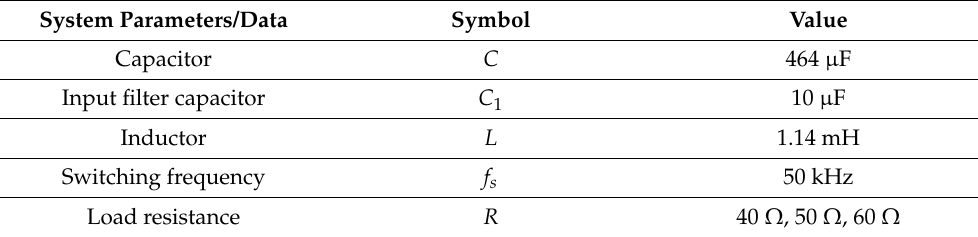
Table 2. DC-DC boost converter